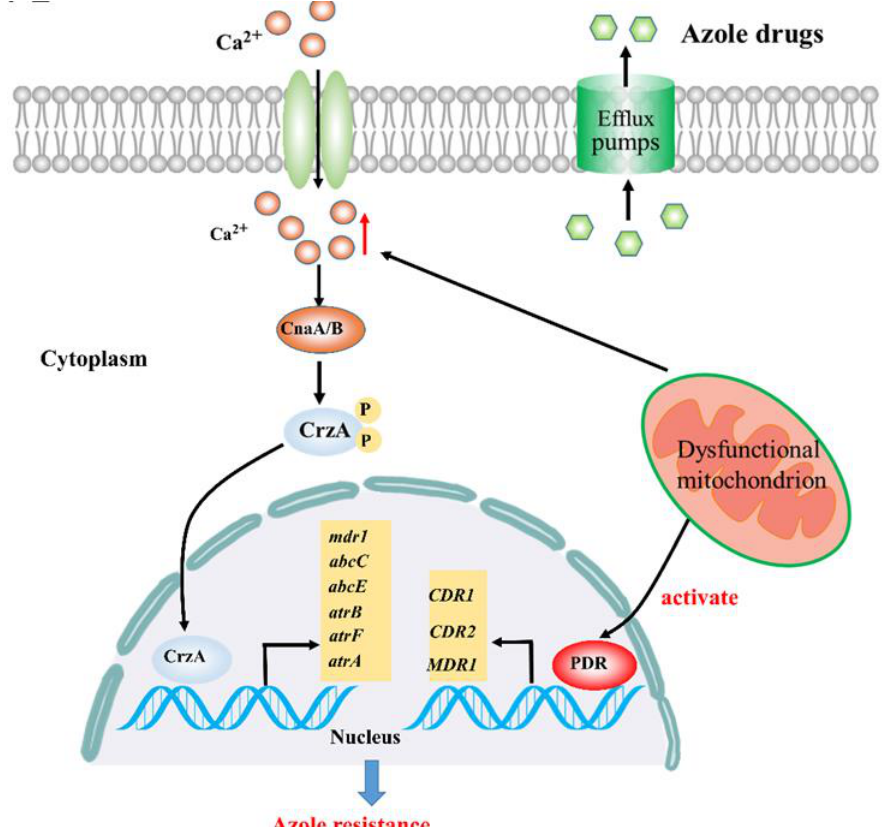
Figure 1. Calcium signaling participates in mitochondria-mediated azole resistance. Abnormal cytoplasmic Ca 2+ transients induced by mitochondrial dysfunction cause a persistent nuclear localization of zinc finger transcription factor CrzA ( C. albicans Crz1 homolog in A. fumigatus ) and, therefore, triggers the global overexpression of multidrug transport genes ( mdr1 , atrB , atrF , abcE , atrA , and abcC ), leading to azole resistance.